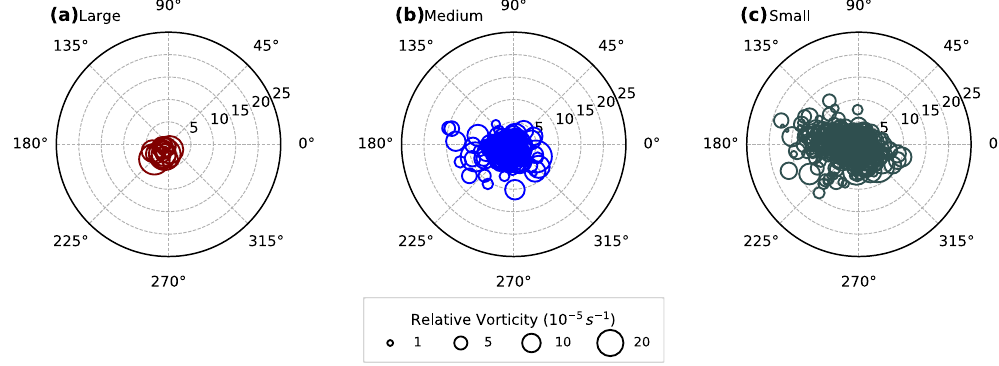
Figure 3. Spatial distribution of rainfall extremes with respect to monsoon low pressure systems (LPSs). Relative locations of the centre of mass of ( a ) large, ( b ) medium and ( c ) small Extreme Rainfall Events (EREs) with respect to the LPS centre (taken as position of the 850 hPa relative vorticity maxima). The origin of the polar plot and bubbles represent the LPS centre and the centre of mass of EREs respectively. The radial distance from the origin is in degrees. The area of the bubble is directly proportional to the relative vorticity (850 hPa) at the LPS centre. For this analysis, the LPSs over the Bay of Bengal and Central India (10°–27°N, 75°–95°E) are considered for the period 1979–2012. The archived LPS track data by Hurley and Boos 23 is used for this